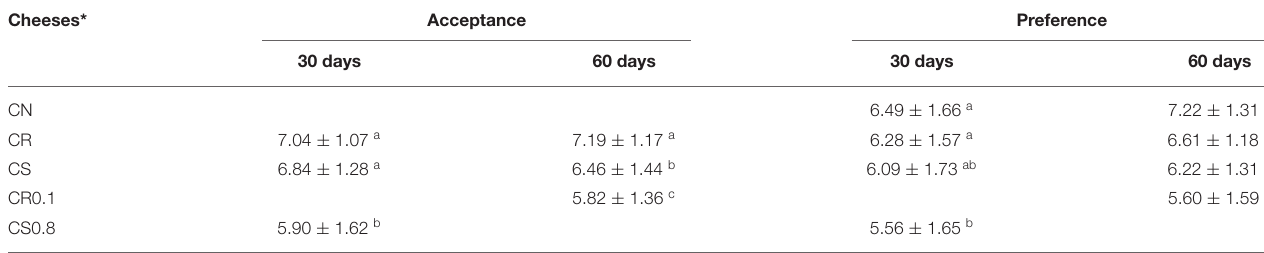
TABLE 9 | Consumer acceptance and preference of cheeses with 30 and 60 days of ripening. Cheeses*